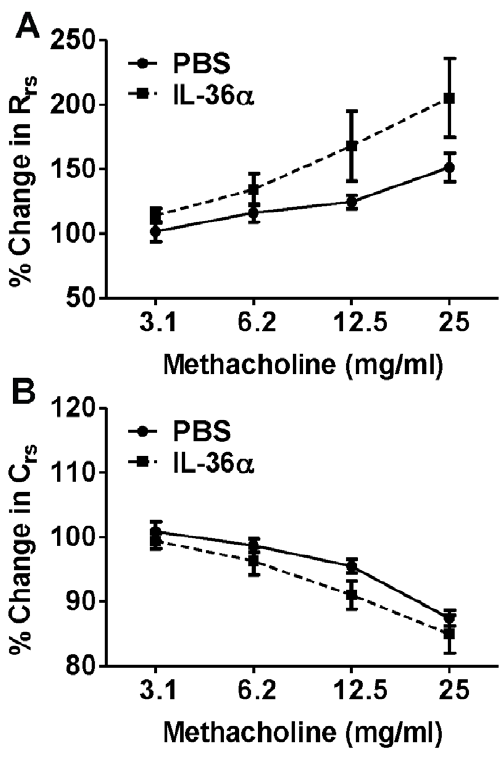
Figure 3. Intratracheal instillation of IL-36 a does not induce airway hypresponsiveness. A) Total lung resistance and B) lung compliance were not significantly different in the lungs of IL-36 a challenged mice compared to PBS controls. Airway responses in mice were measured using invasive plethysmography 24 h following i.t instillation of IL-36 a or PBS. Data presented are percentage changes from baseline (0mg/mL) measurements. Data represent mean 6 SEM from 5–7